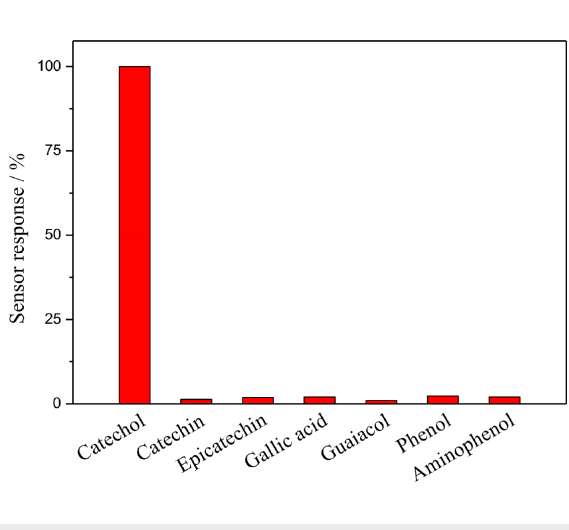
Figure 9: Relative responses of the laccase – Nafion–ECNFs/GCE for different phenolic compounds (catechol, catechin, epicatechin, gallic acid, guaiacol, phenol and aminophenol; 100 µM in 0.2 M acetate buffer (pH 5.5), respectively).